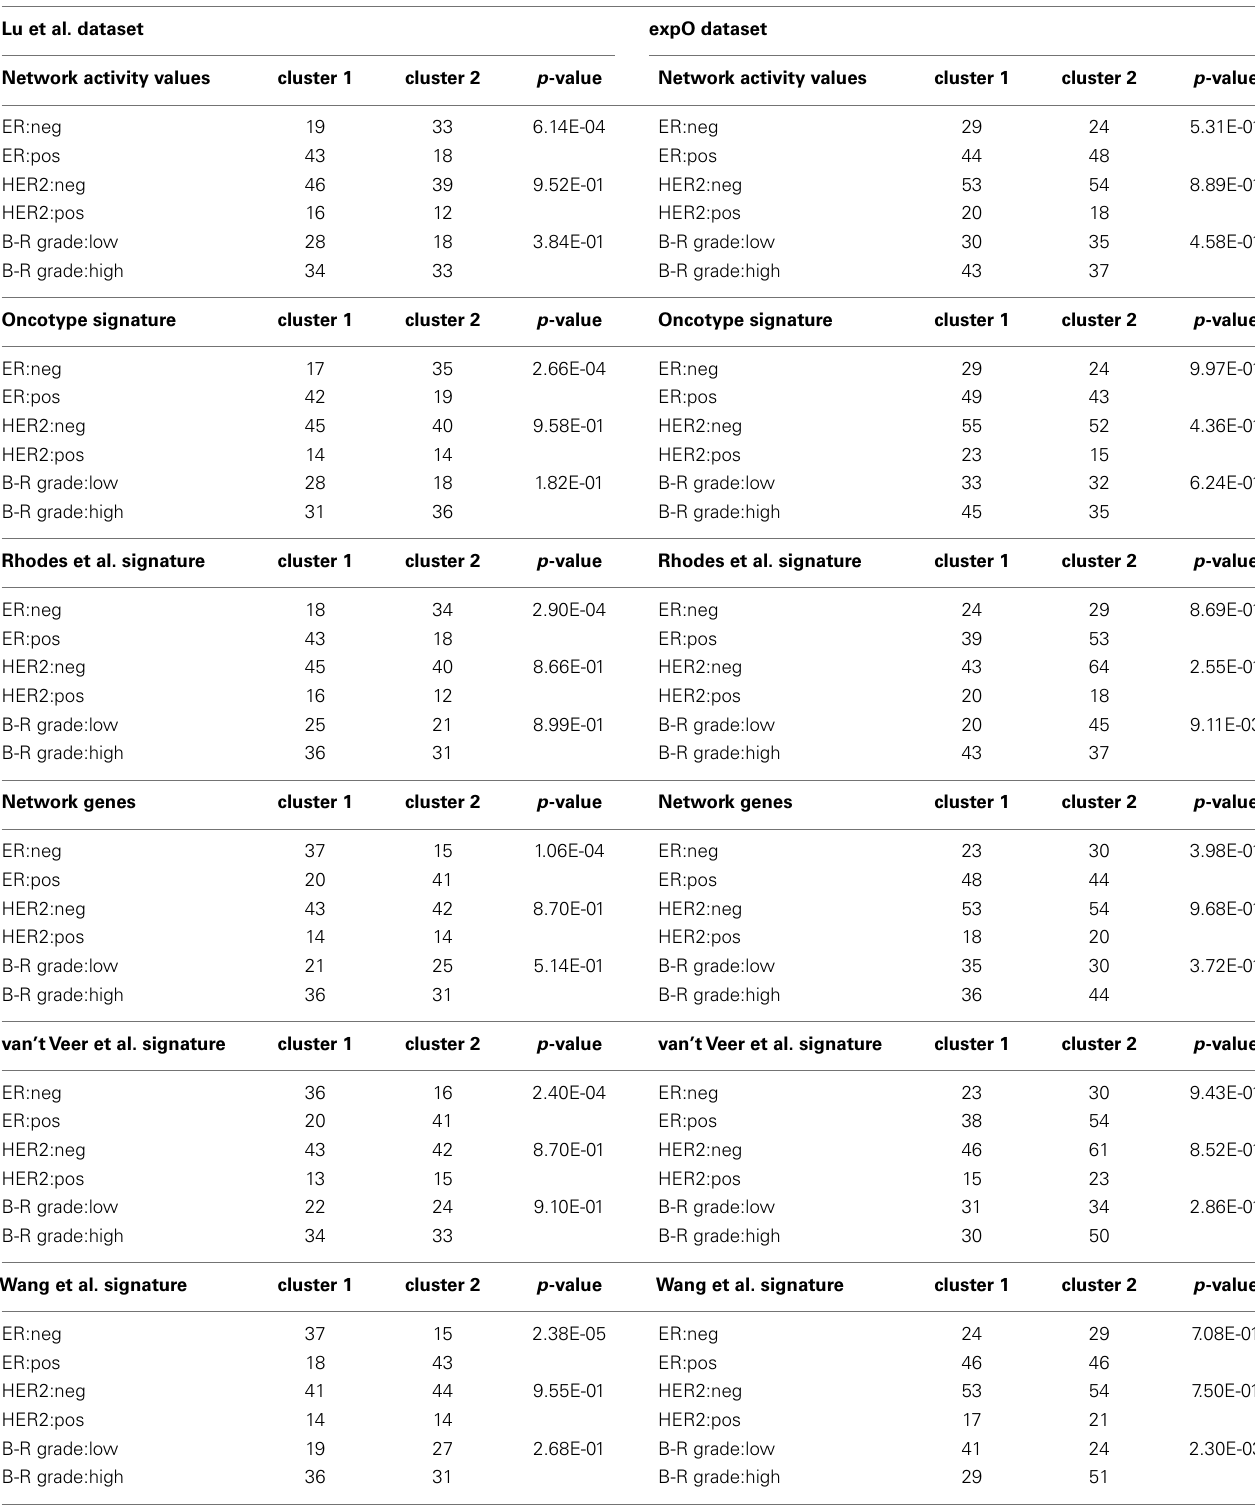
Table 1 | k -Means clustering of breast cancer